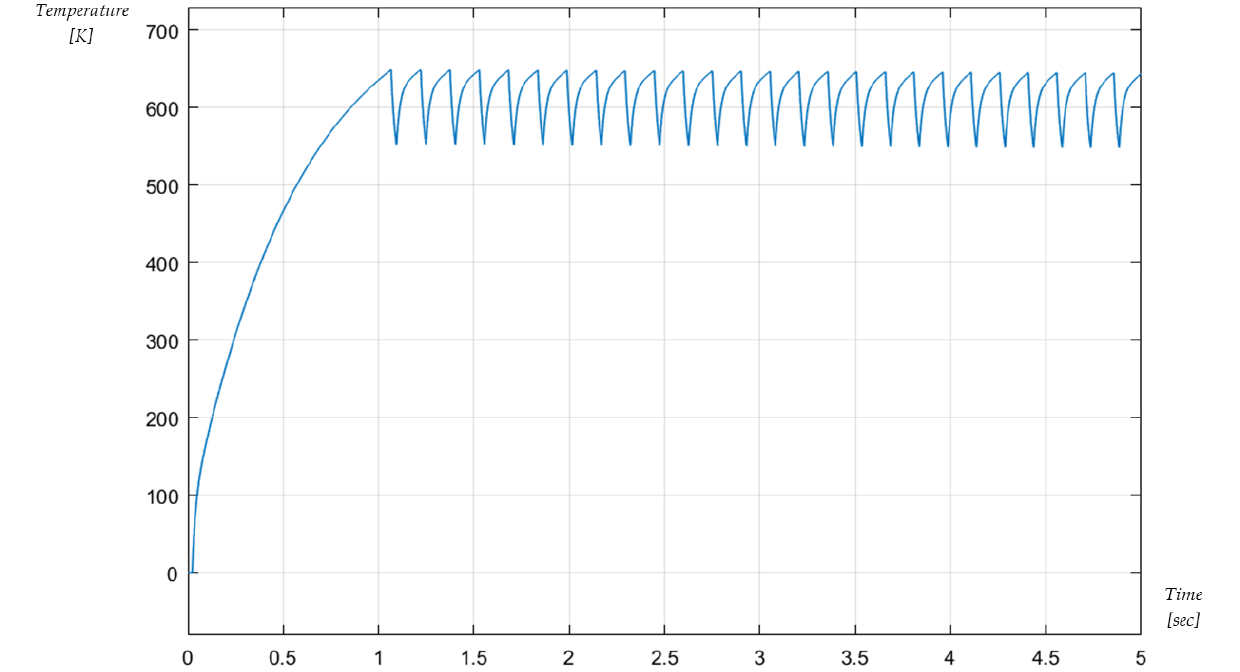
Figure 10. PID controller applied in a thermal manufacturing process modelled as a switched system: tracking efficiency. The controller was empirically calibrated.